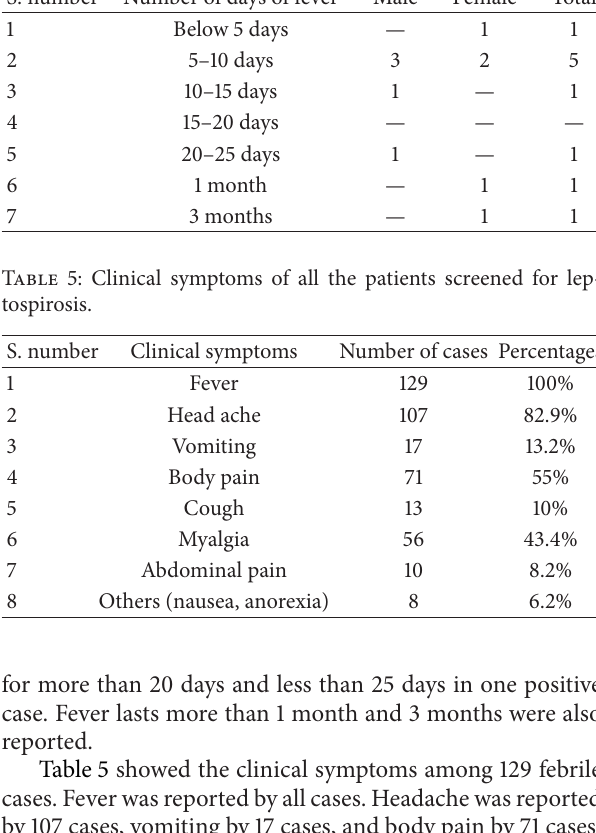
Table 1: Prevalence of leptospiral antibodies among patients and rats screened.